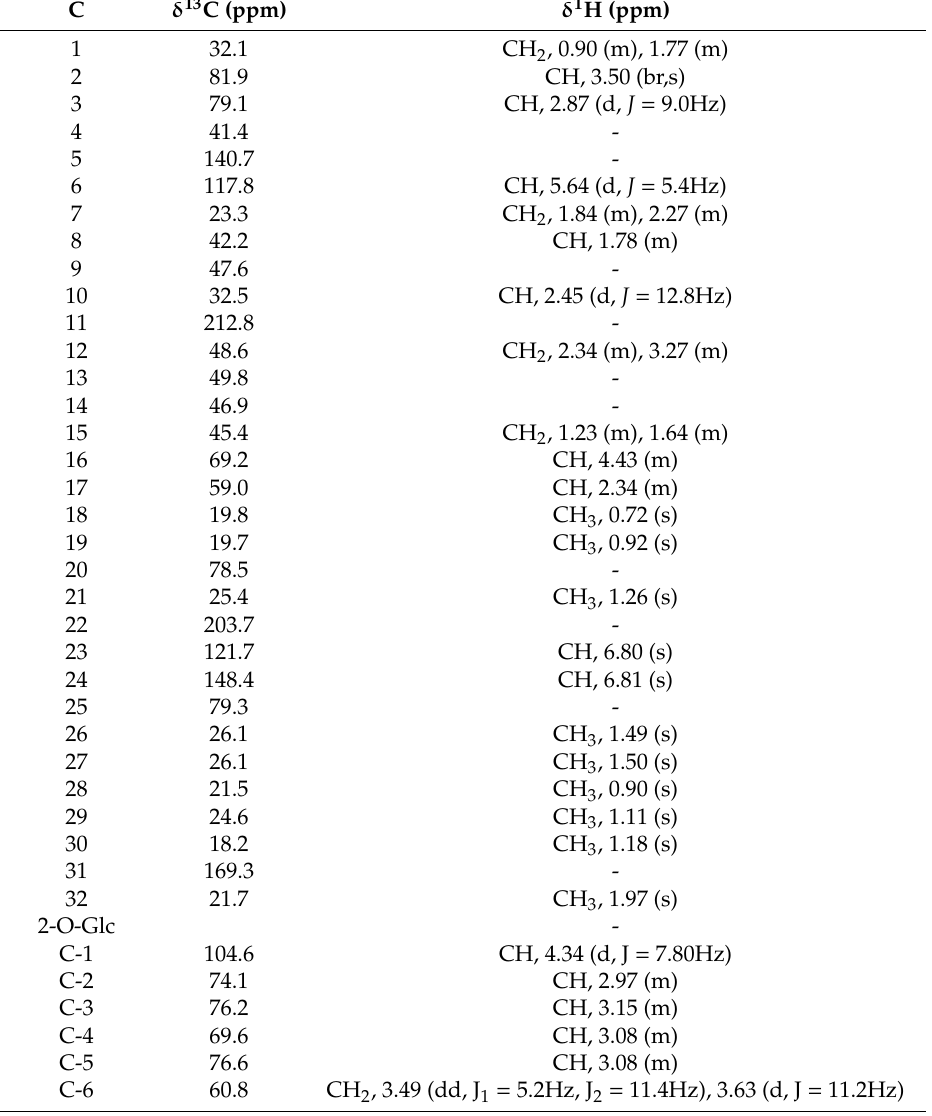
Table2. 1 HNMRand 13 CNMRofcucurbitacinF25-acetate2-O- β -D-glucosideinDimethylsulfoxide-d 6